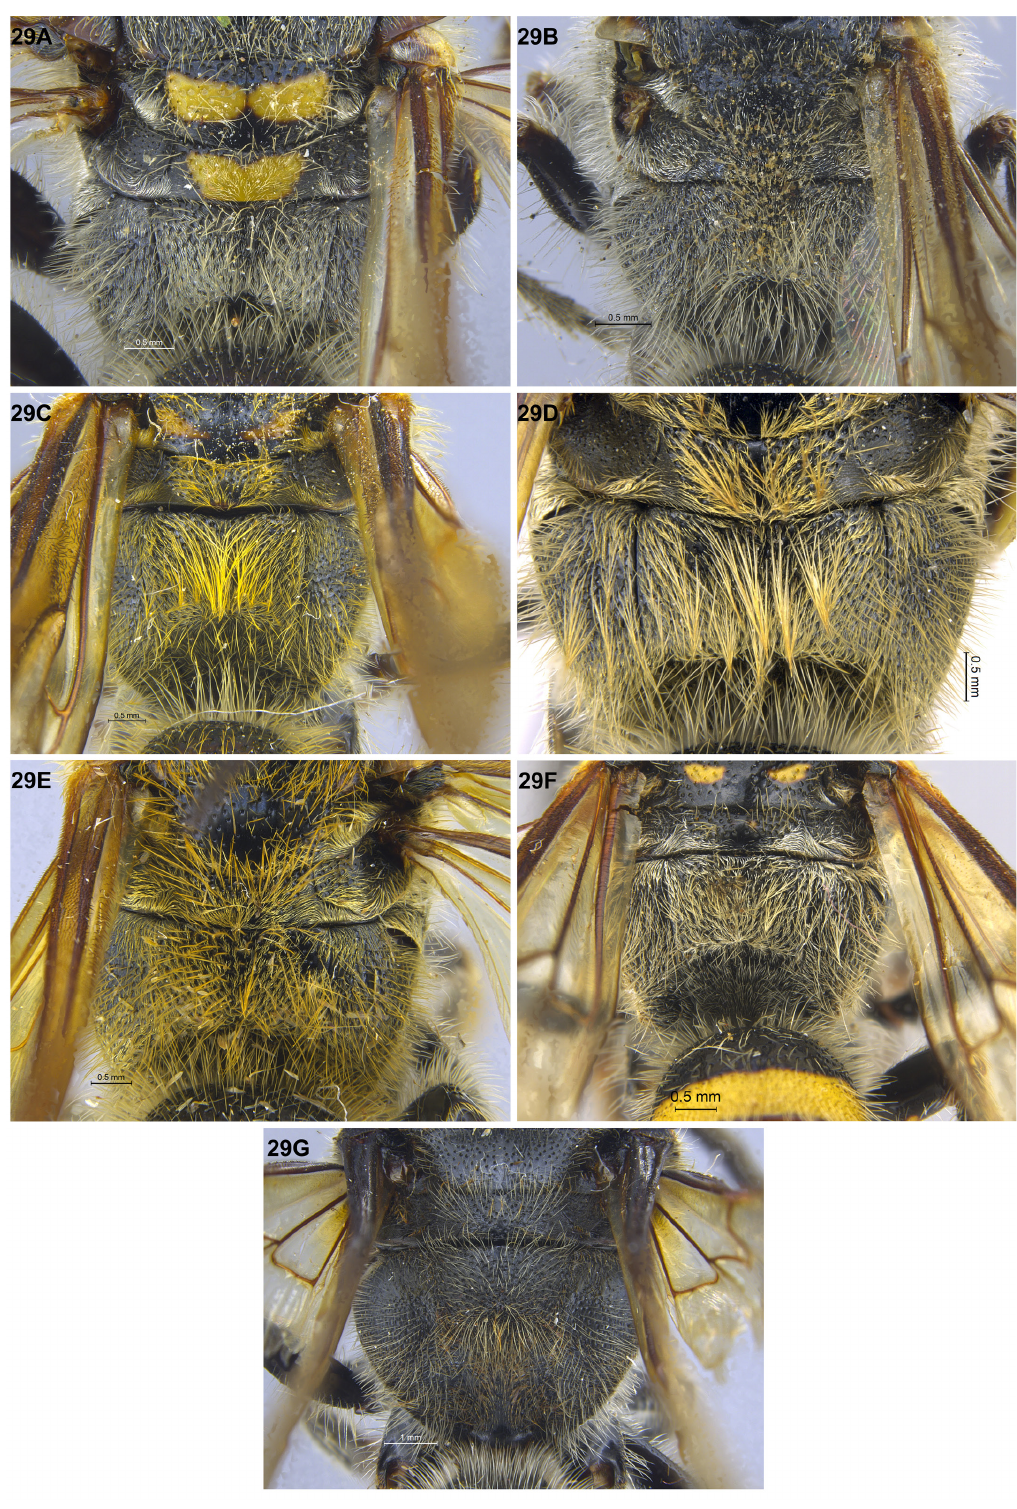
Fig. 29. Males, propodeum. A . Campsomeriella annulata annulata (Fabricius, 1793). B . Camps. collaris (Fabricius, 1775). C . Megacampsomeris sp. 1. D . Megacam. formosensis chinensis Betrem, 1941. E . Megacam. prismatica (Smith, 1855). F . Phalerimeris phalerata phalerata (de Saussure, 1858). G . Sericocampsomeris flavomaculata Gupta & Jonathan,